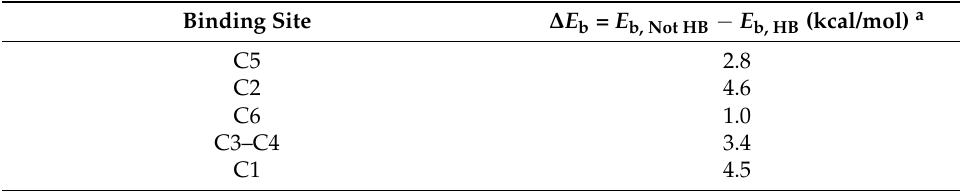
Table 4. Effect of hydrogen bonding between cysteinyl –NH 3+ and DQ on binding